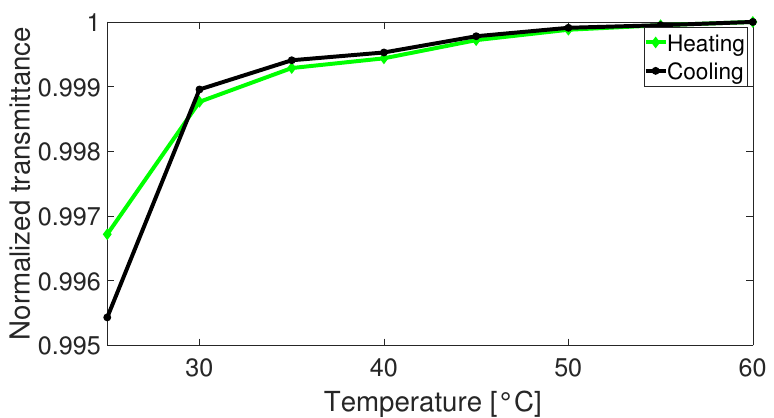
Figure 7. Simulation of the change of the optical transmission with increasing temperature for the heating and cooling process applied to the SWW.